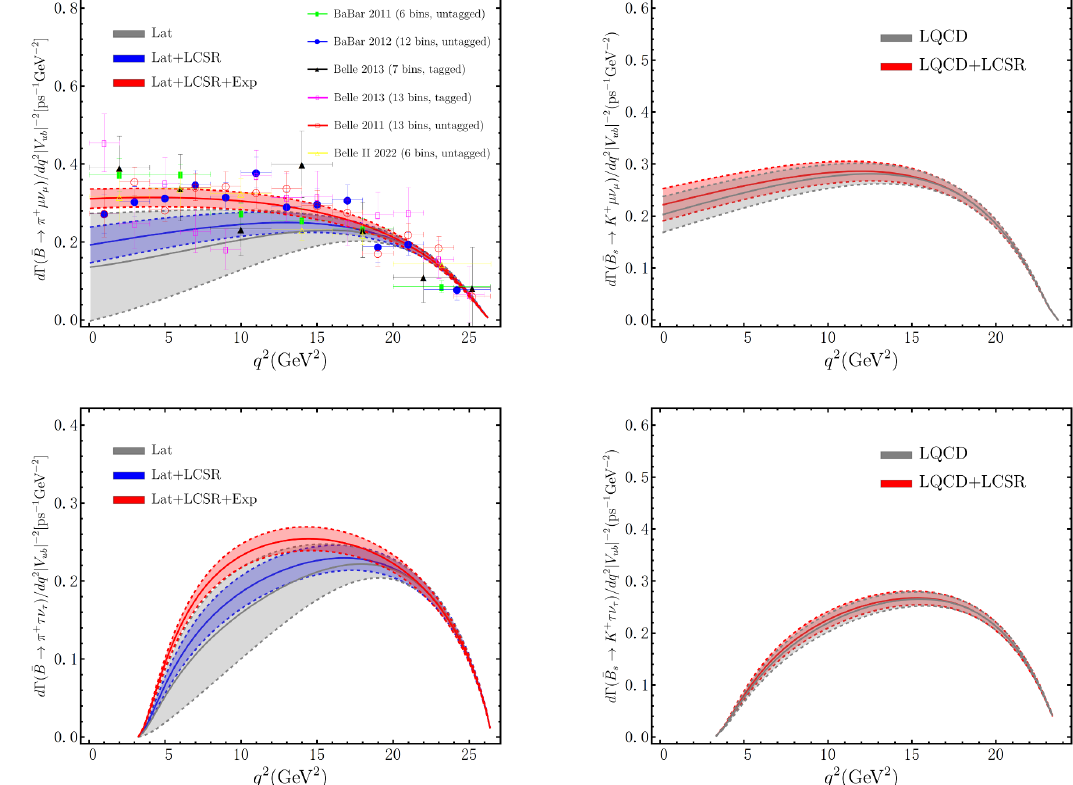
Figure 12 . Theory predictions for the differential q 2 distributions of the exclusive semileptonic B → π‘ ¯ ν ‘ (left panel) and B s → K‘ ¯ ν ‘ (right panel) decay processes in the entire kinematic region with the distinct BCL z -series fits of the form-factor shape parameters. The available experimental measurements on the binned q 2 distributions of the “golden” decay process B → πµ ¯ ν from the BaBar [62, 63], Belle [64, 65] and Belle II [66] Collaborations are further displayed for an exploratory